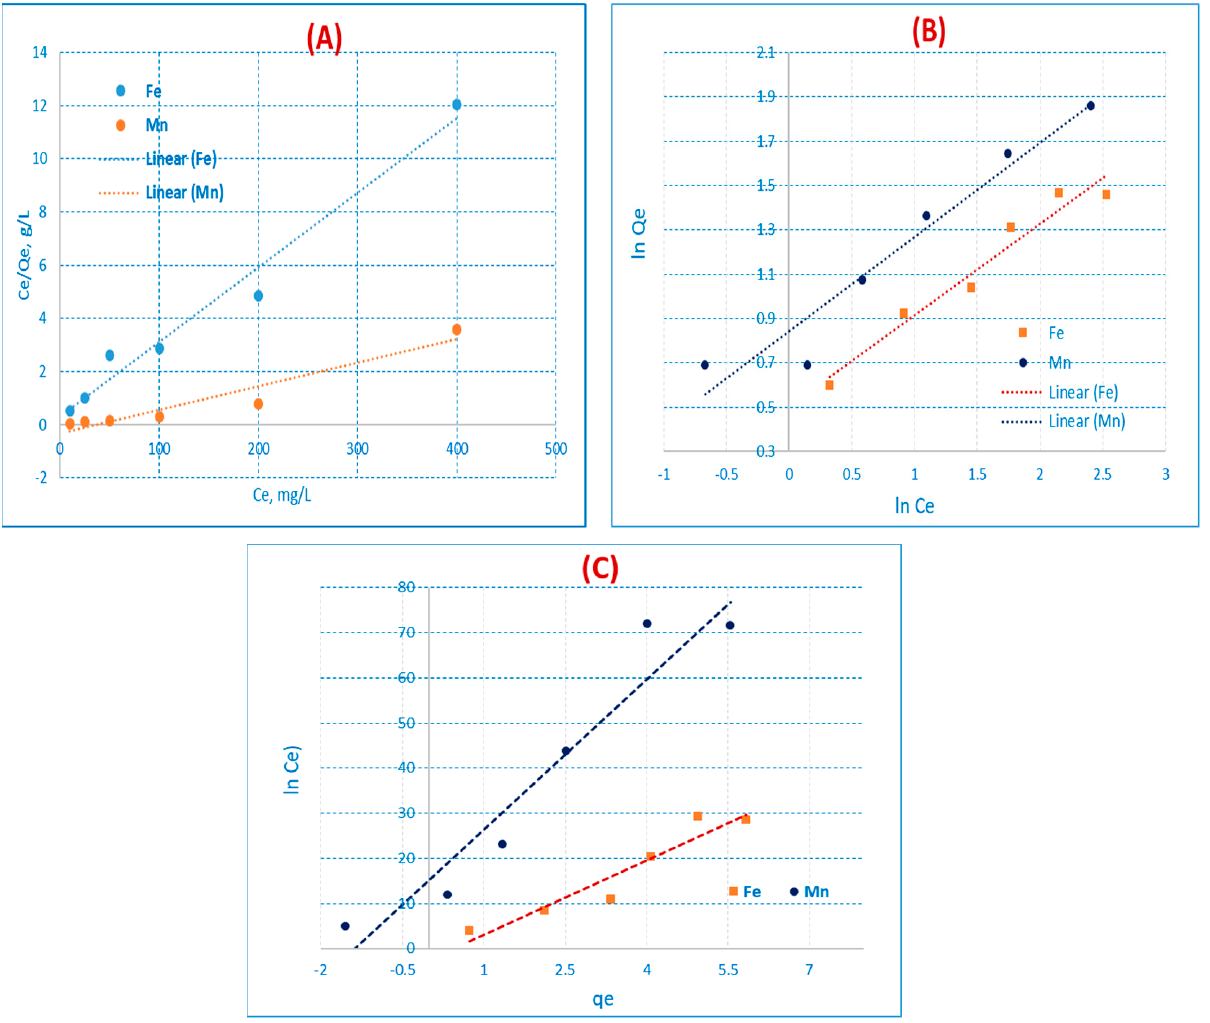
Figure 8 . Langmuir ( A ), Freundlich ( B ), Temkin ( C ) isotherm plots for the adsorption of Fe(III) and Mn(II) using AC(C − 3). Table 10. Parameters of Langmuir and Freundlich for Fe(III) and Mn(II) adsorption using AC(C-3),